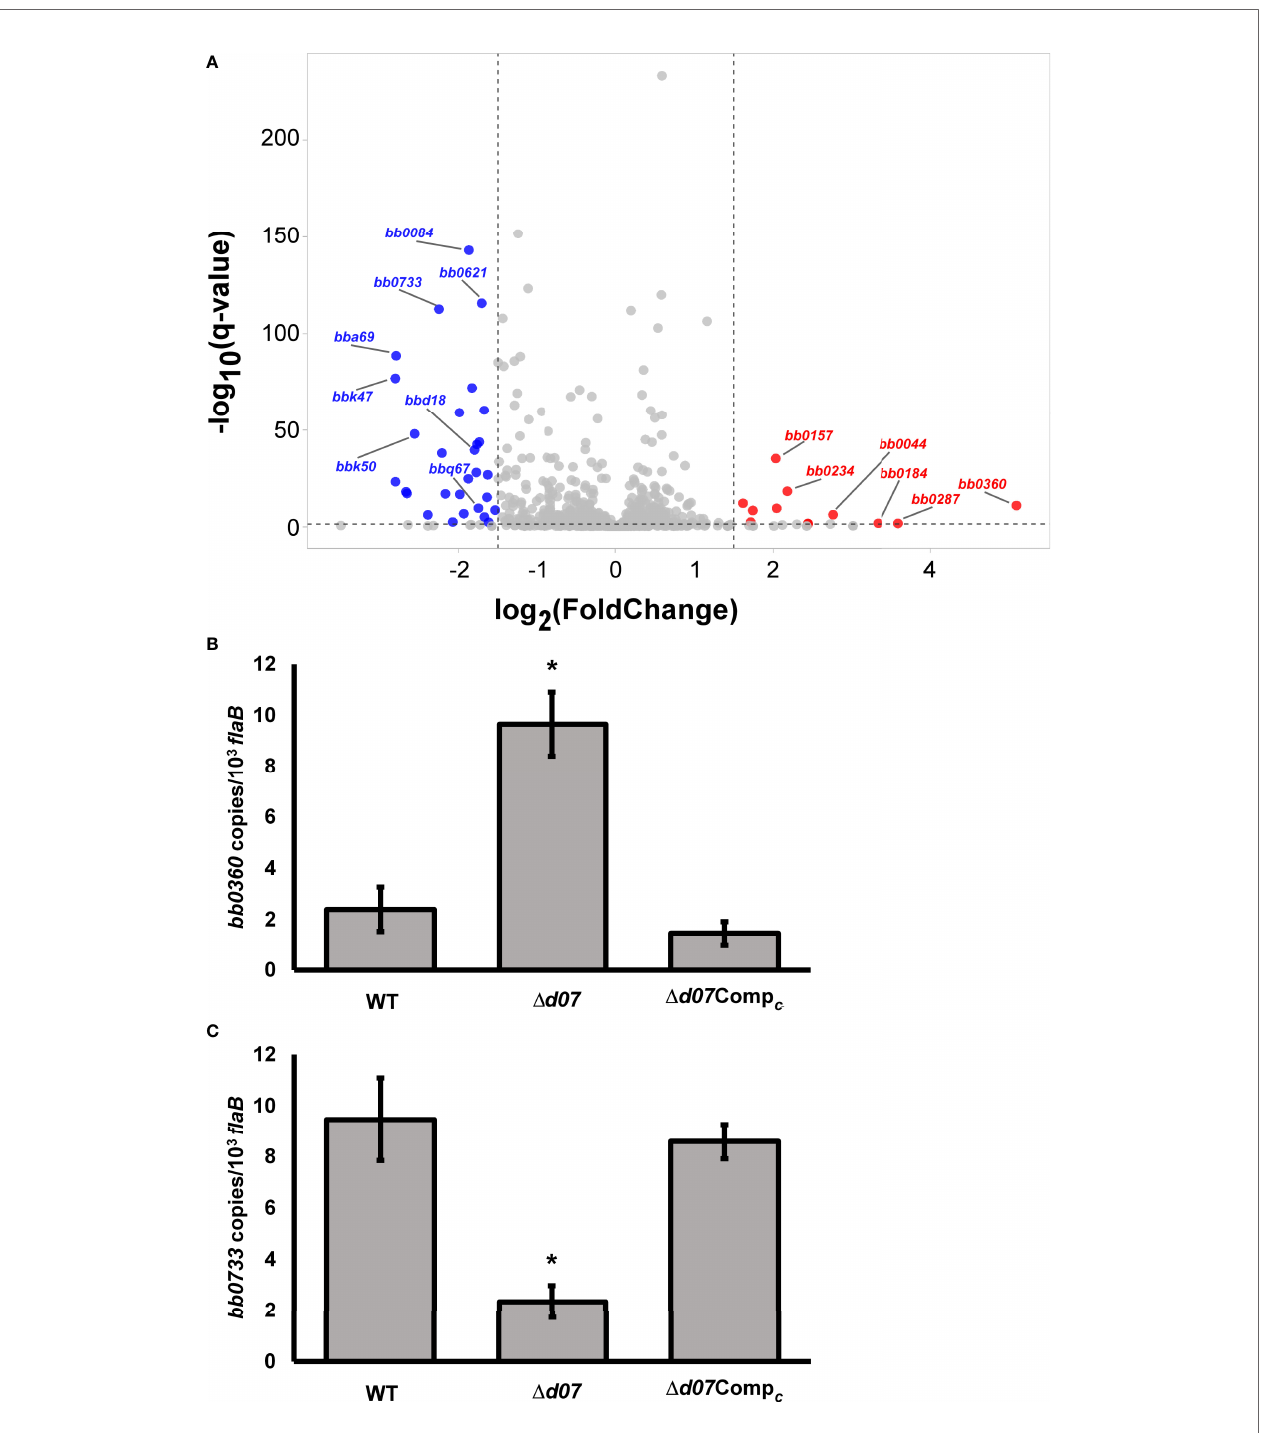
FIGURE 6 | bbd07 deletion results in an altered in vitro transcriptome. (A) Volcano plot illustrating differentially expressed genes (DEGs) following targeted deletion of bbd07. DEGs with a positive Log 2 fold change were expressed at a greater level in D d07 than in wild type and are shown as red dots. DEGs with negative Log 2 fold change were expressed at lower level in D d07 than in wild type and are shown as blue dots. Red and blue dots correspond to genes with log 2 -fold change in expression of ±1.5, and with a -Log 10 (qvalue) greater than 1.5. (B, C) qRT-PCR analysis comparing relative transcription of bb0360 (B) and bb0733 (C) between indicated strains. Each bar represents the average value from three unpooled biological replicates (cultures) per strain, with three technical replicates performed for each biological replicate. Error bars indicate SEM among biological replicates (n = 3). Asterisk indicates statistically different group ( P < 0.05) as determined by one ‐ way ANOVA followed by all pairwise multiple comparison (Holm ‐